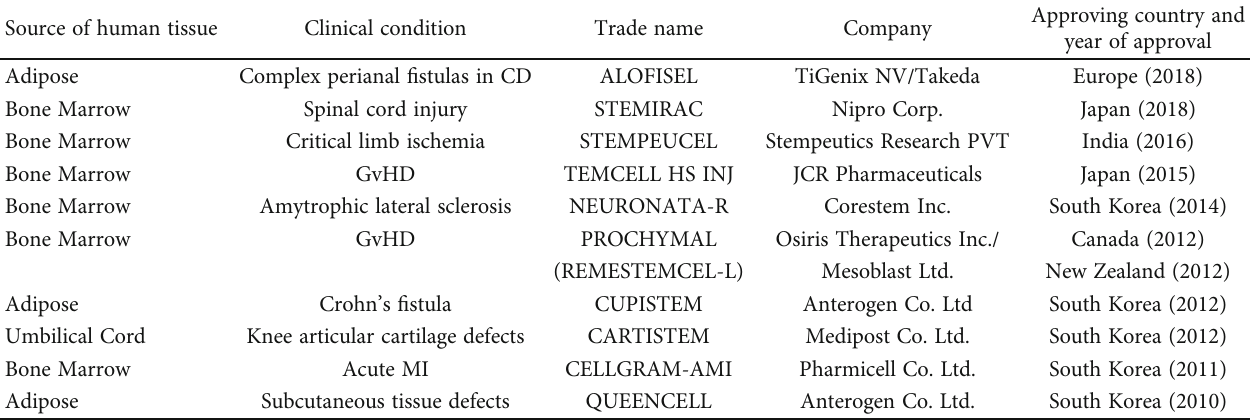
Figure 4: Skin cell therapy overview. Patients own cultured cells or allogeneic cells can be (a) used directly on the wound site, (b) applied using as an aerosol, or (c) cell replacement supported under a wound dressing with a wound capillary system. Table 1: Current MSC-approved products for human clinical